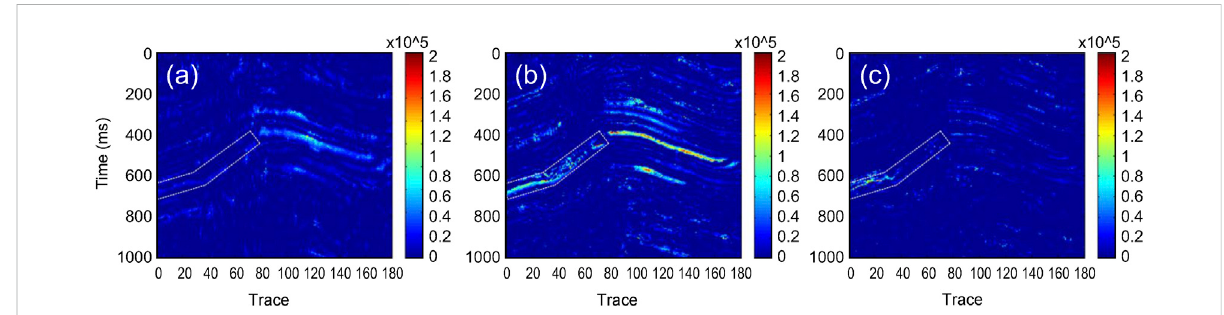
FIGURE 9 Isofrequency pro fi le of data processed by the improved synchrosqueezing transform (SST). (A) 20 Hz-isofrequency pro fi le; (B) 30 Hz- isofrequency pro fi le; and (C) 40 Hz-isofrequency pro fi le. The white dotted box marks the location of the gas-bearing reservoir (these are all plotted with MATLAB, with the “ jet ” colormap; red indicates higher